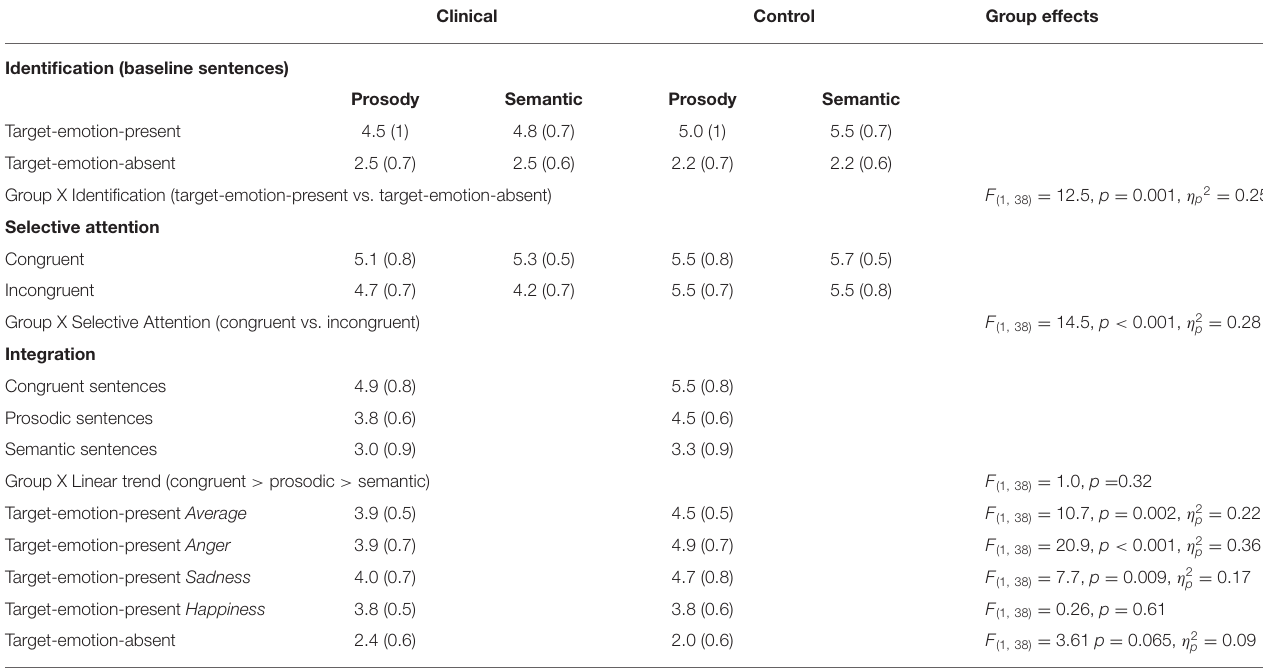
TABLE 2 | Summary of ratings (Means and SD s), averaged across target emotions, for the forensic patients with schizophrenia and the control group, with F values of the comparison.